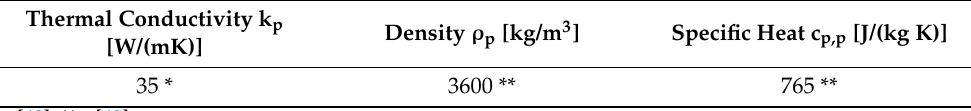
Table 1. Properties of Al 2 O 3